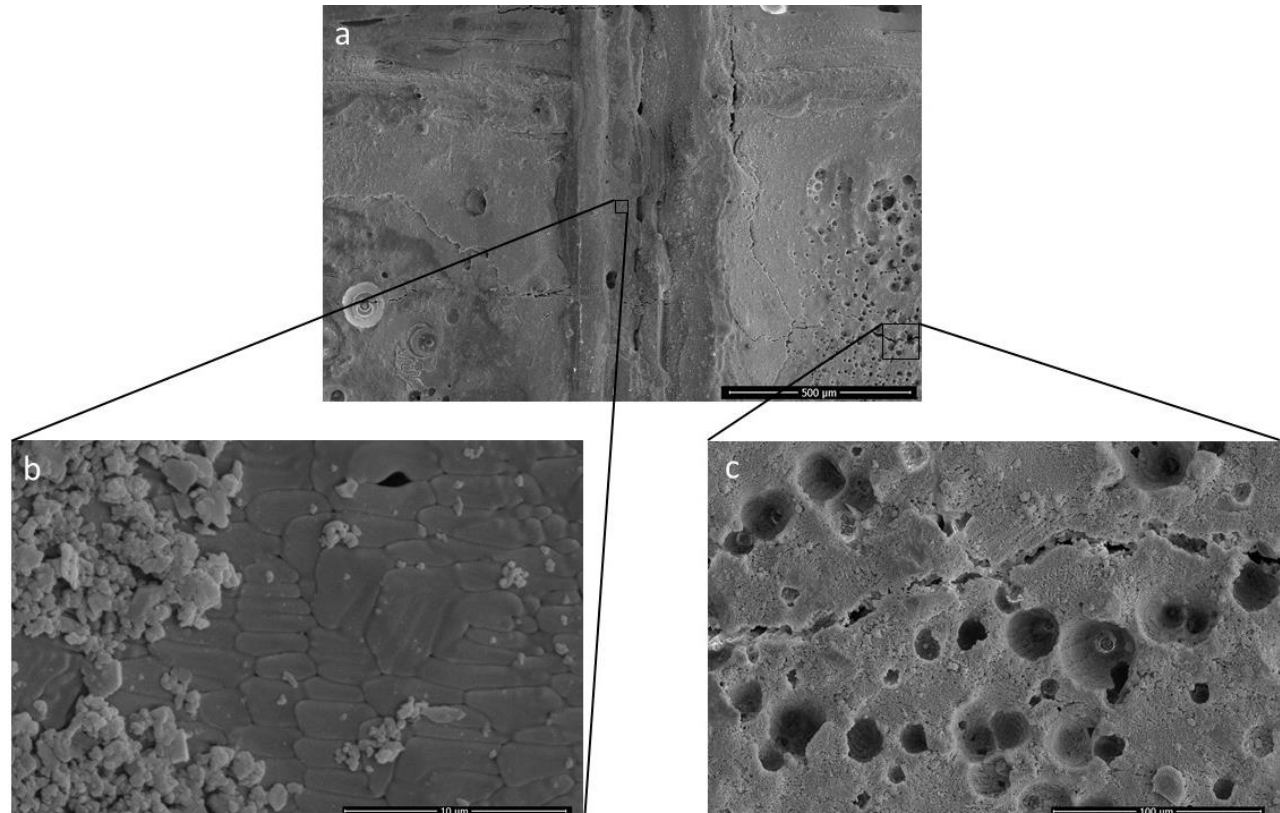
Figure 3. ( a ) Laser scanning strategy. ( b ) SEM of the article in region of the scanning strategy.